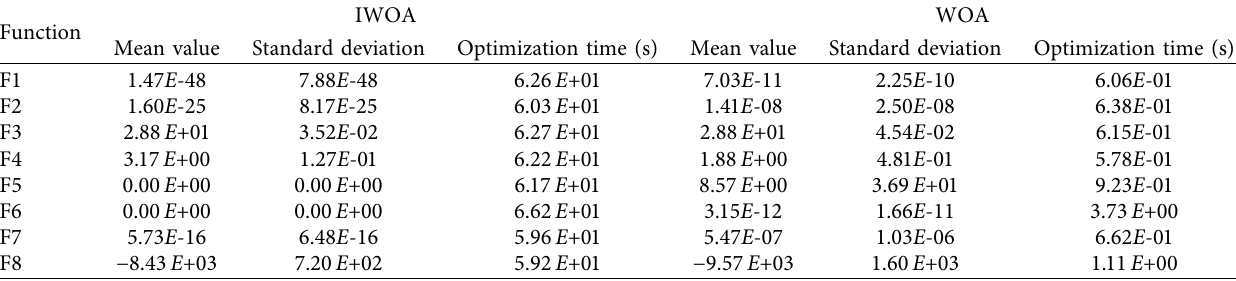
Table 1: Comparison of experimental results.